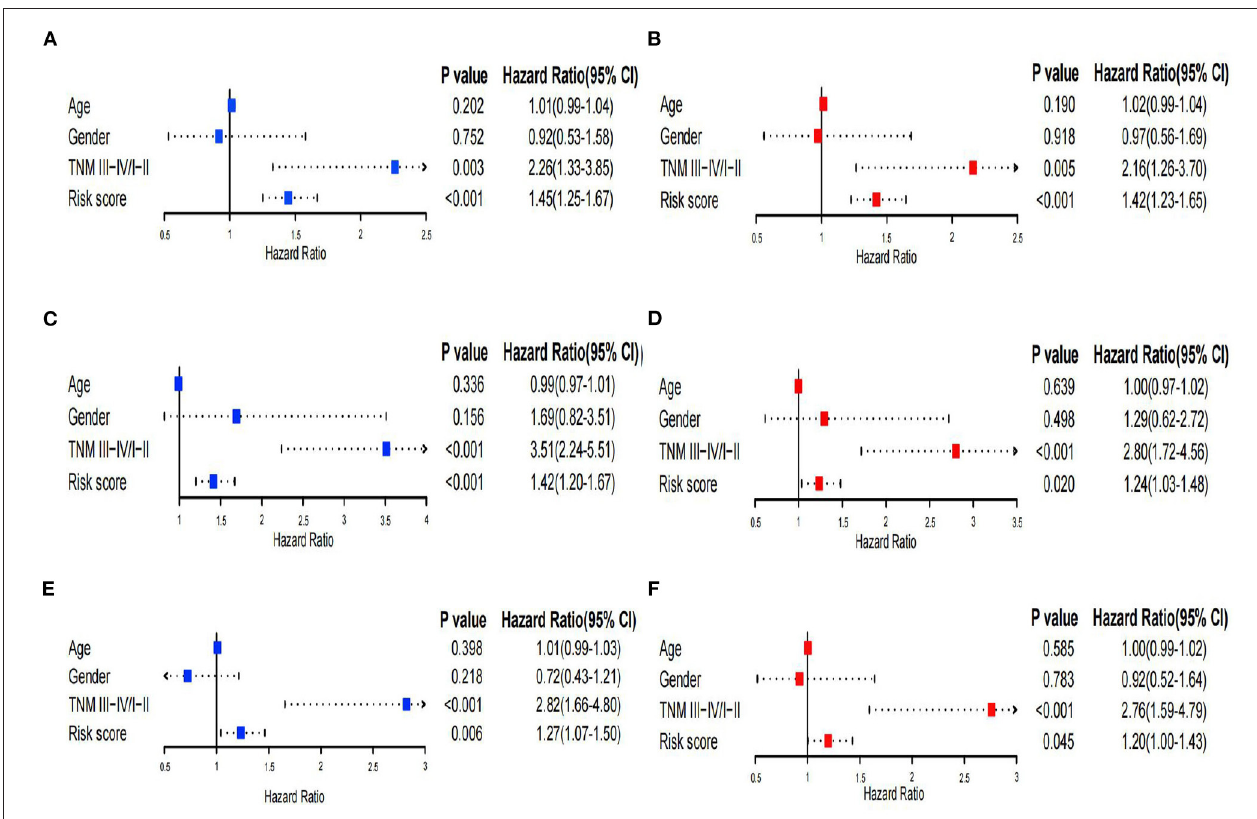
FIGURE 6 | Univariate and multivariate Cox regression analysis. (A,B) Univariate and multivariate Cox analyses of the TCGA training set. (C,D) Univariate and multivariate Cox analyses of GSE14520. (E,F) Univariate and multivariate Cox analyses of the TCGA validation